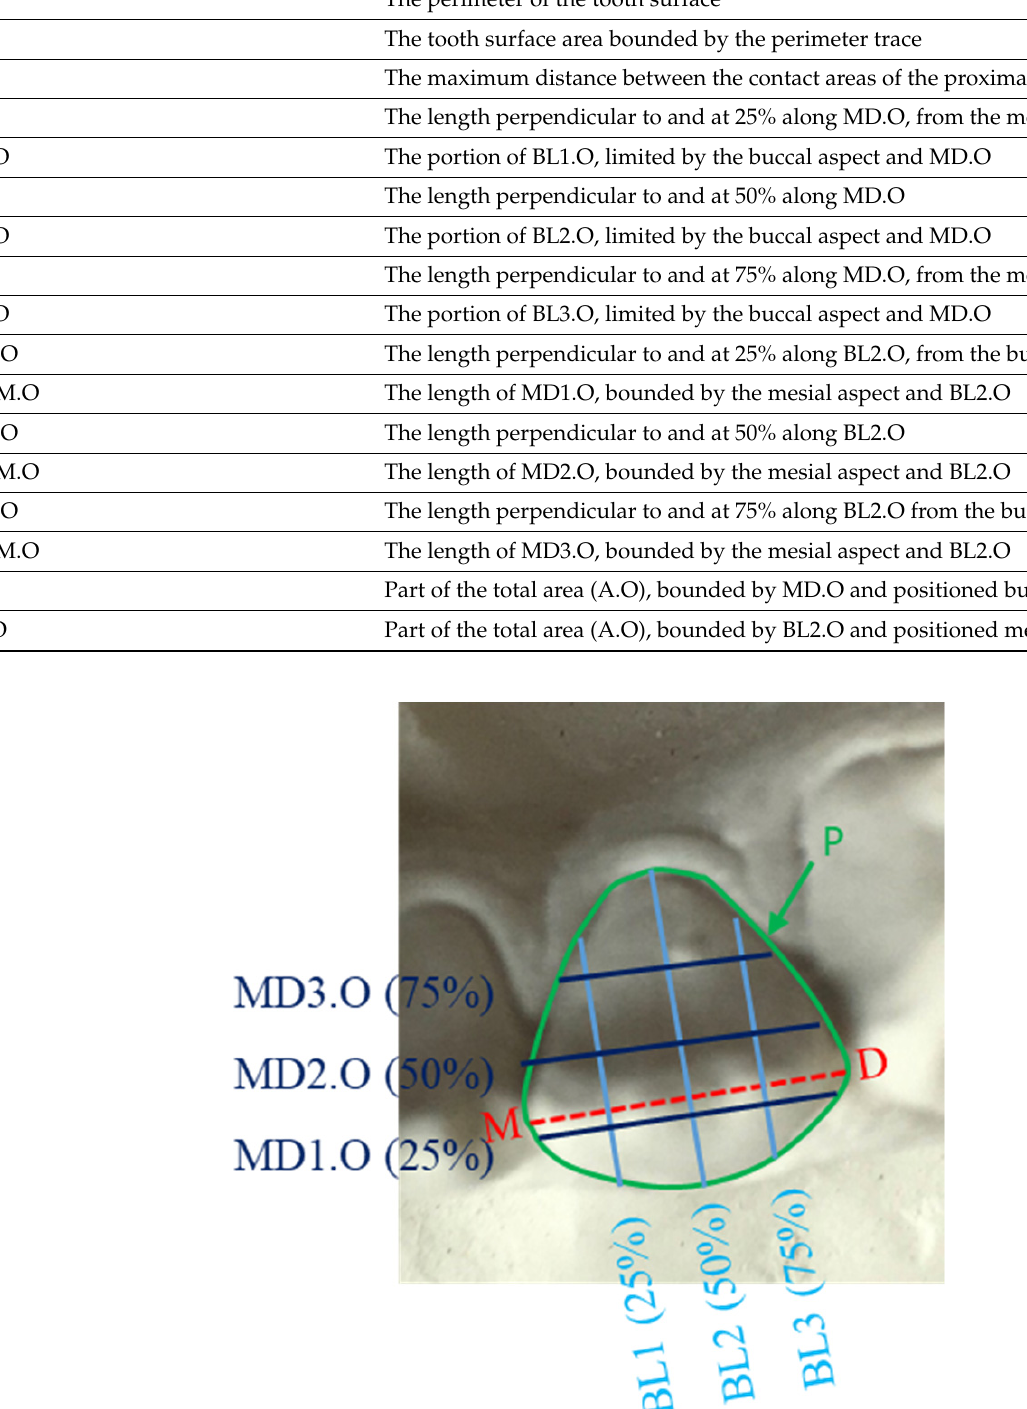
Figure 4. Occlusal view of a lower left lateral incisor partial measurements: MD1M.O, MD2M.O and MD3M.O are the mesial parts of the mesio ‐ distal measurements at 25, 50 and 75% along BL2, re ‐ spectively and determined by BL2; BL1B, BL2B and BL3B are the buccal parts of the bucco ‐ lingual measurements at 25, 50 and 75% along the MD, respectively and determined by the MD. Measurements taken from the labial view and bounded by the periphery of the tooth were: the standard mesio ‐ distal and occluso ‐ gingival dimensions, as well as additional occluso ‐ gingival dimensions at 25 and 75% of the mesio ‐ distal line; and additional mesio ‐ distal dimensions at 25, 50 and 75% of the occluso ‐ gingival diameter (Figures 1 and 2). Similarly, from the occlusal view the measurements were: the standard mesio ‐ distal and labio ‐ lingual dimensions, as well as additional labio ‐ lingual dimensions at 25 and 75% of the mesio ‐ distal line; and additional mesio ‐ distal dimensions at 25, 50 and 75% of the la ‐ bio ‐ lingual diameter (Figures 2 and 4). Measurements from the right and left mandibular incisors were averaged as there were no significant differences in the variance between right and left sides within patients as compared to the variance between patients using intra ‐ class correlation coefficients. Principal component analysis (PCA) was used to summarize the measurements and re ‐ duce the number of variables to a meaningful number of key factor variables representing